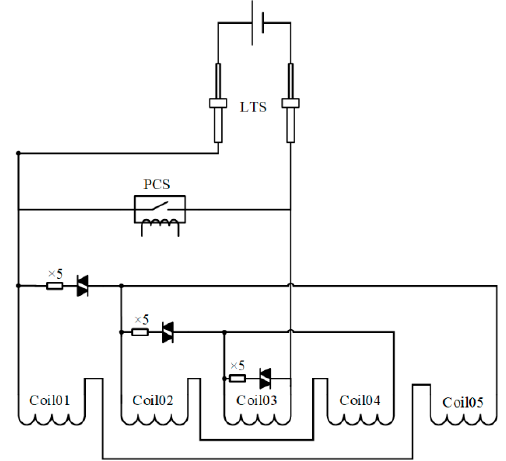
Figure 9. Quench protection circuit diagram.